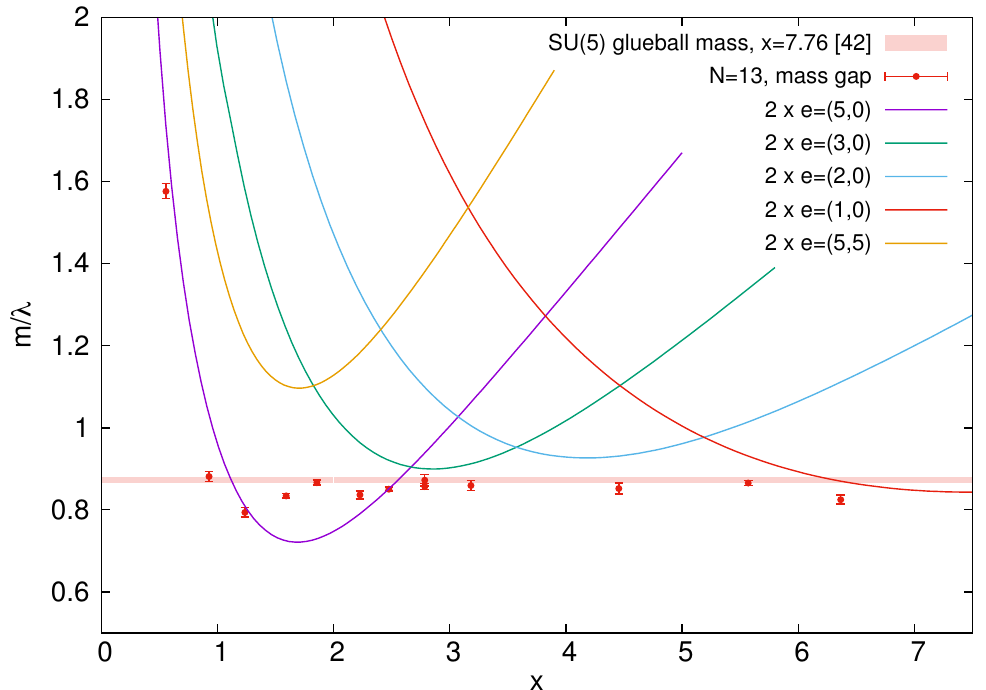
Figure 11. x -dependence of the mass gap in the zero-electric (cid:13)ux sector for the Fibonacci set f N; k g = f 13 ; 5 g . The continuous lines give twice the torelon energy in the corresponding electric (cid:13)ux